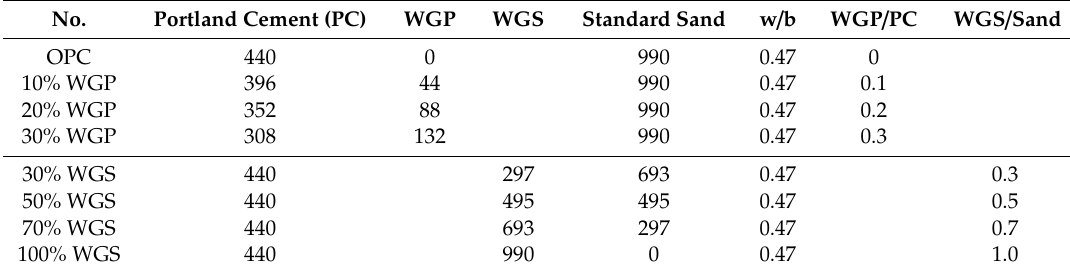
Table 4. Mixture design for the volume stability test of WGP and WGS (kg / m 3 ). WGP, waste glass powder; WGS, waste glass